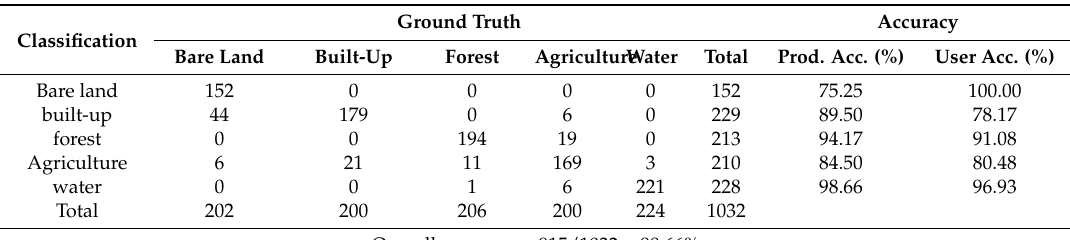
Table 4. Error matrix of the automatic supervised classification (ASC).